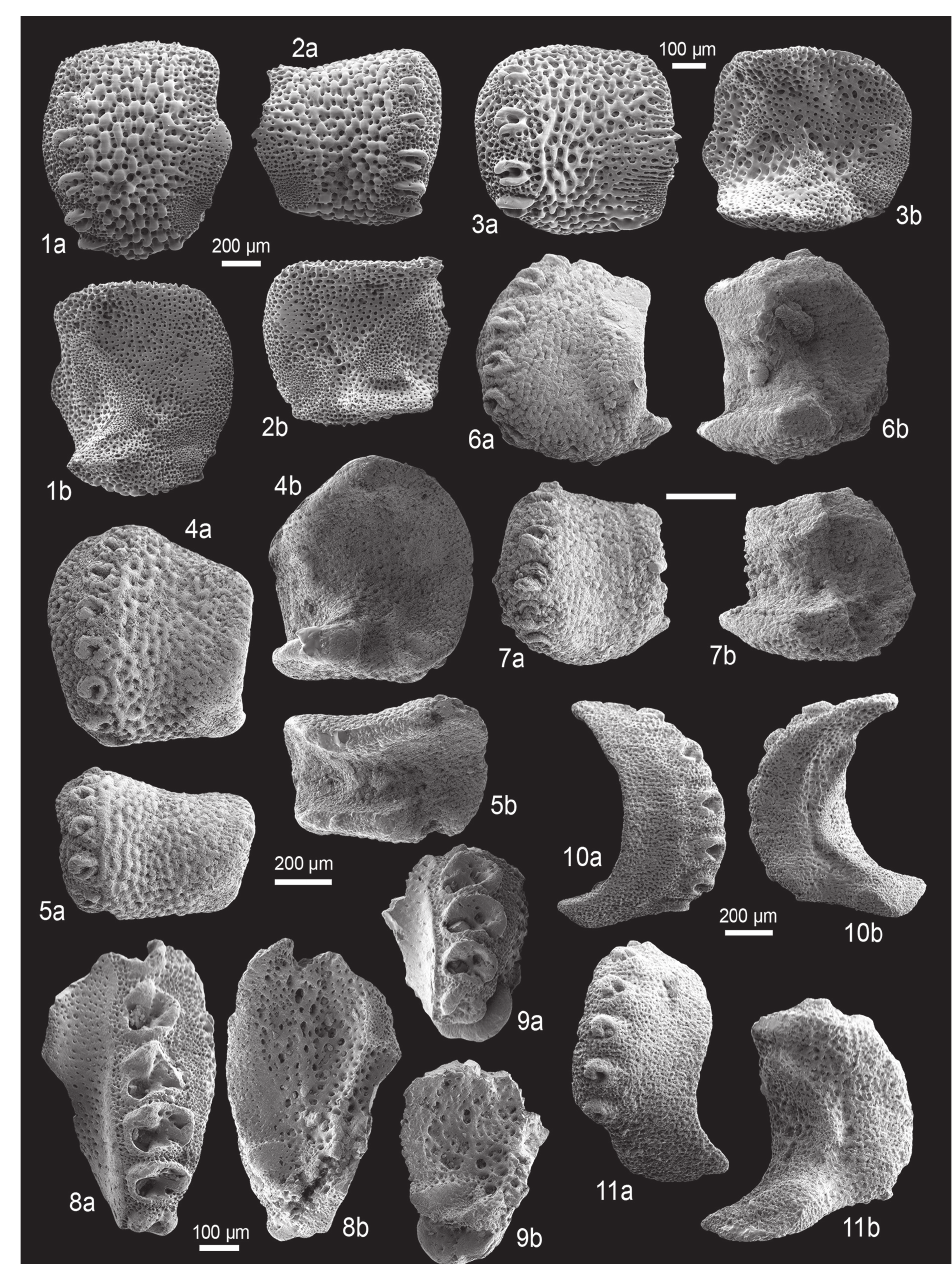
Fig. 37. Lateral arm plates (LAPs) of fossil and Recent ophiacanthid brittle stars in external (a) and internal (b) views. 1-2. Ophiochondrus convolutus Lyman, 1869, Recent. 1. Proximal LAP. 2. Median LAP. 3. Ophiochondrus stelliger Lyman, 1879, Recent; proximal LAP. 4-5. Ophiochondrus punctatus (Kutscher & Jagt, 2000) comb. nov. from the early Maastrichtian (Early Cretaceous) of Rügen, Germany. 4. GZG.INV.78775, proximal LAP. 5. GZG.INV.78776, distal LAP. 6-7. Ophiochondrus ? semirotundus (Kutscher & Jagt, 2000) comb. nov. from the early Maastrichtian of Rügen, Germany. 6. GZG.INV.78800, proximal LAP. 7. GZG.INV.78801, median LAP. 8-9. Ophiacanthidae gen. et sp. nov. innom. from the late Oxfordian (Late Jurassic) of the Plettenberg, Germany. 8. GZG.INV.78802, proximal LAP. 9. GZG.INV.78803, median or distal LAP. 10-11. Ophiojagtus argoviensis (Hess, 1966) comb. nov. from the late Oxfordian (Late Jurassic) of Savigna, France. 10. NHMB M1124, proximal LAP. 11. NHMB M11225, proximal to median LAP. One common scale bar per